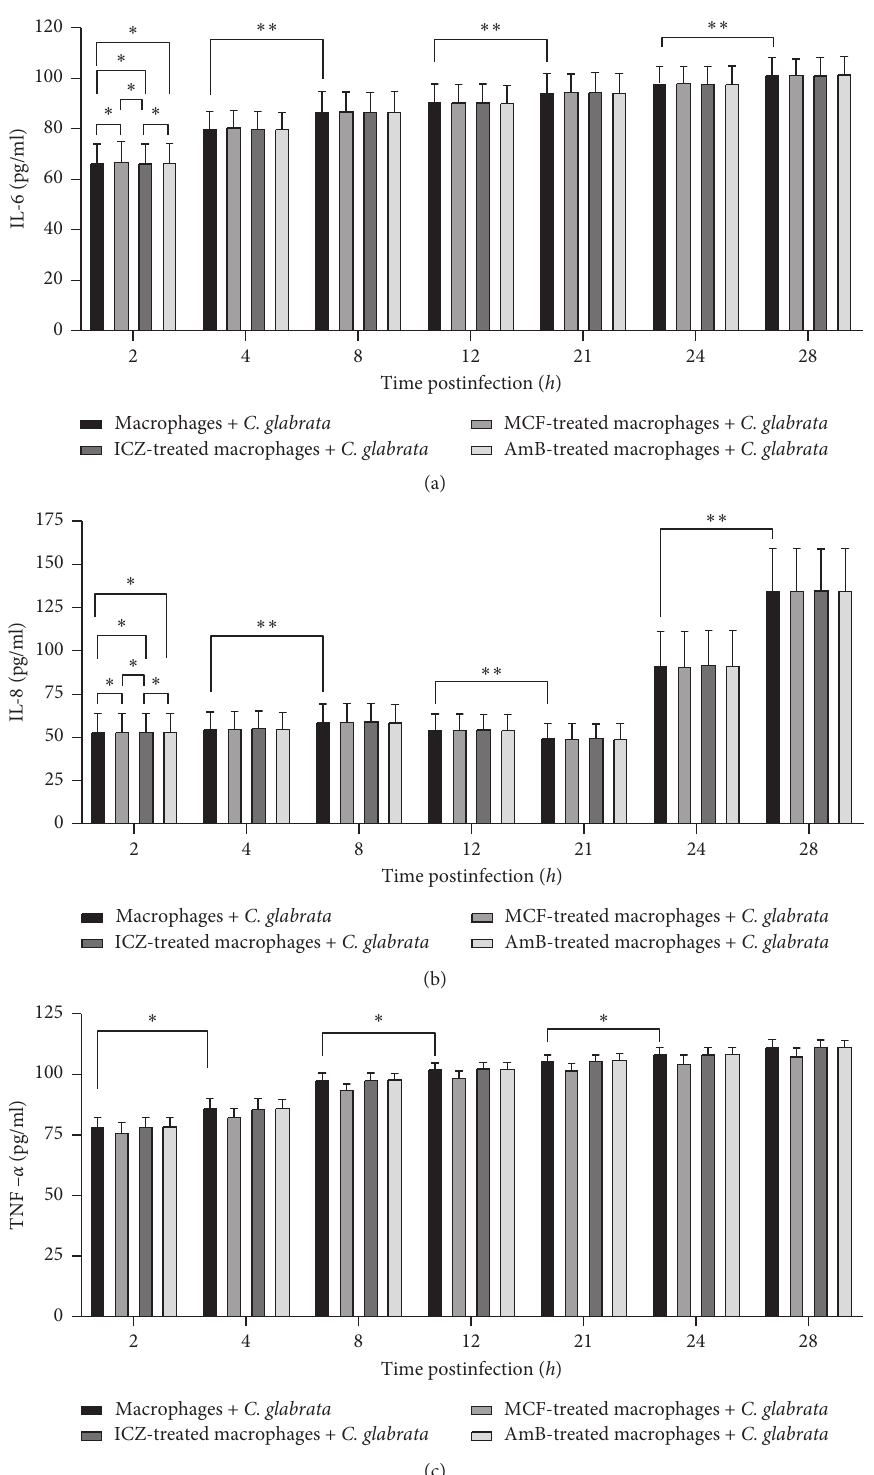
Figure 2: Effects of different antifungal drugs on the secretion of IL-6, IL-8, and TNF- α from macrophages infected by C. glabrata . The levels of secreted IL-6, IL-8, and TNF- α were determined by ELISA. IL-6 levels secreted by the four groups of macrophages were not statistically significant ( ∗ , P > 0 . 05), and IL-6 levels secreted at different time points were significantly different ( F � 6562.399, ∗∗ , P < 0 . 001). At all-time points, IL-6 levels gradually increased over time (a). IL-8 levels secreted by the four groups of macrophages were not statistically significant ( ∗ , P > 0 . 05), and IL-8 levels secreted at different time points were statistically significant ( F � 828.076, ∗∗ , P < 0 . 001). At all-time points, IL-8 levels fluctuated with time (b). TNF- α levels secreted at different time points were statistically significant ( F � 2237.196, ∗ , P < 0 . 001). At all- time points, TNF- α levels gradually increased over time